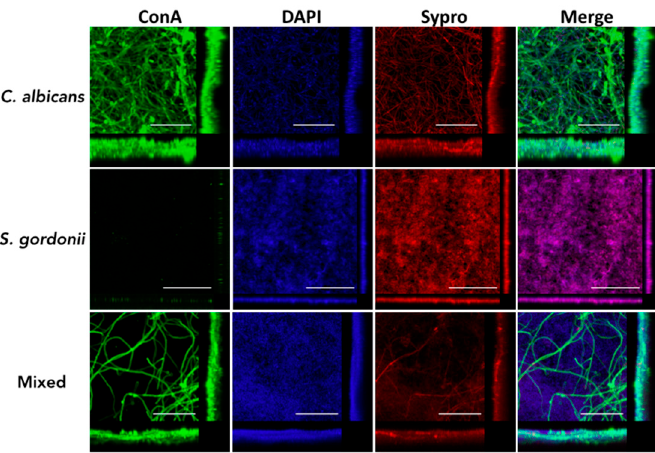
6 of 11 Figure 2. SEM micrographs of C. albicans and S. gordonii single- and dual-species biofilms grown in 1:1 v / v RPMI/THB + 0.02% YE media (upper panel) and BMM synthetic saliva (lower panel) formed on titanium discs. Magnification ×500. We also used confocal laser scanning microscopy (CLSM) to further examine the main architectural features and three-dimensional characteristics of C. albicans and S. gordonii single- and dual-species biofilms formed on the titanium discs, using both 1:1 media and BMM synthetic saliva. Confirming results from metabolic readouts obtained using Presto Blue, both C. albicans and S. gordonii were able to form robust single-species biofilms on the titanium alloy surface using 1:1 media (Figure 3); however, this was not the case in BMM synthetic saliva (Figure 4). For example, although filamentation was observed in C. albicans single-species biofilms formed in BMM synthetic saliva, the resulting biofilm on the titanium surface showed less confluency and overall thickness when compared with an equivalent biofilm formed in 1:1 media. Likewise, S. gordonii single-species biofilms formed in BMM synthetic saliva consisted of relatively sparse microcolonies, as opposed to a much more confluent and dense biofilm covering the entire the titanium surface when formed using 1:1 media (compare Figures 3 and 4). The interactions between the two microorganisms resulted in a much higher